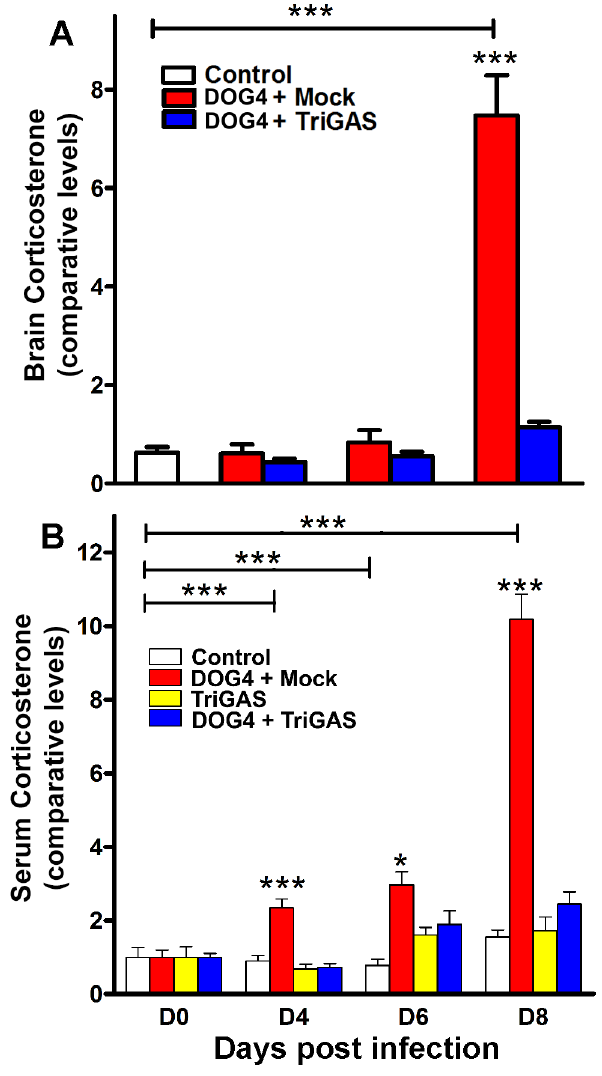
Figure 5. Postexposure treatment of DOG4 RV-infected mice with TriGAS prevents the elevation of corticosterone associat- ed with pathogenic RABV in brain and serum. A) Mice were infected i.n. with 10 5 FFU of DOG4 and 4 hr later either mock treated with PBS or treated with 10 7 FFU of TriGAS. An additional group of uninfected, untreated mice served as a reference. Six mice per group were euthanized for each time point, and the levels of brain corticosterone were determined via LC-GC/MS-MS2 as described in Materials and Methods. B) Groups were identical to those in A), with one additional group of animals receiving only TriGAS. Ten mice per group were bled at each time point and serum corticosterone was measured by EIA as described in Materials and Methods. The results represent comparative levels of corticosterone ( + / 2 SE) *p , .05, **p , .01, and ***p , .001,